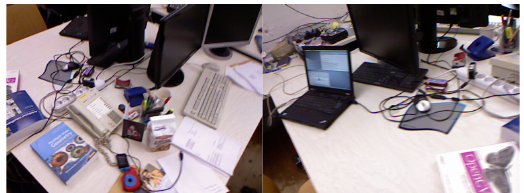
Figure 9. Sample images of fr1_desk sequence.